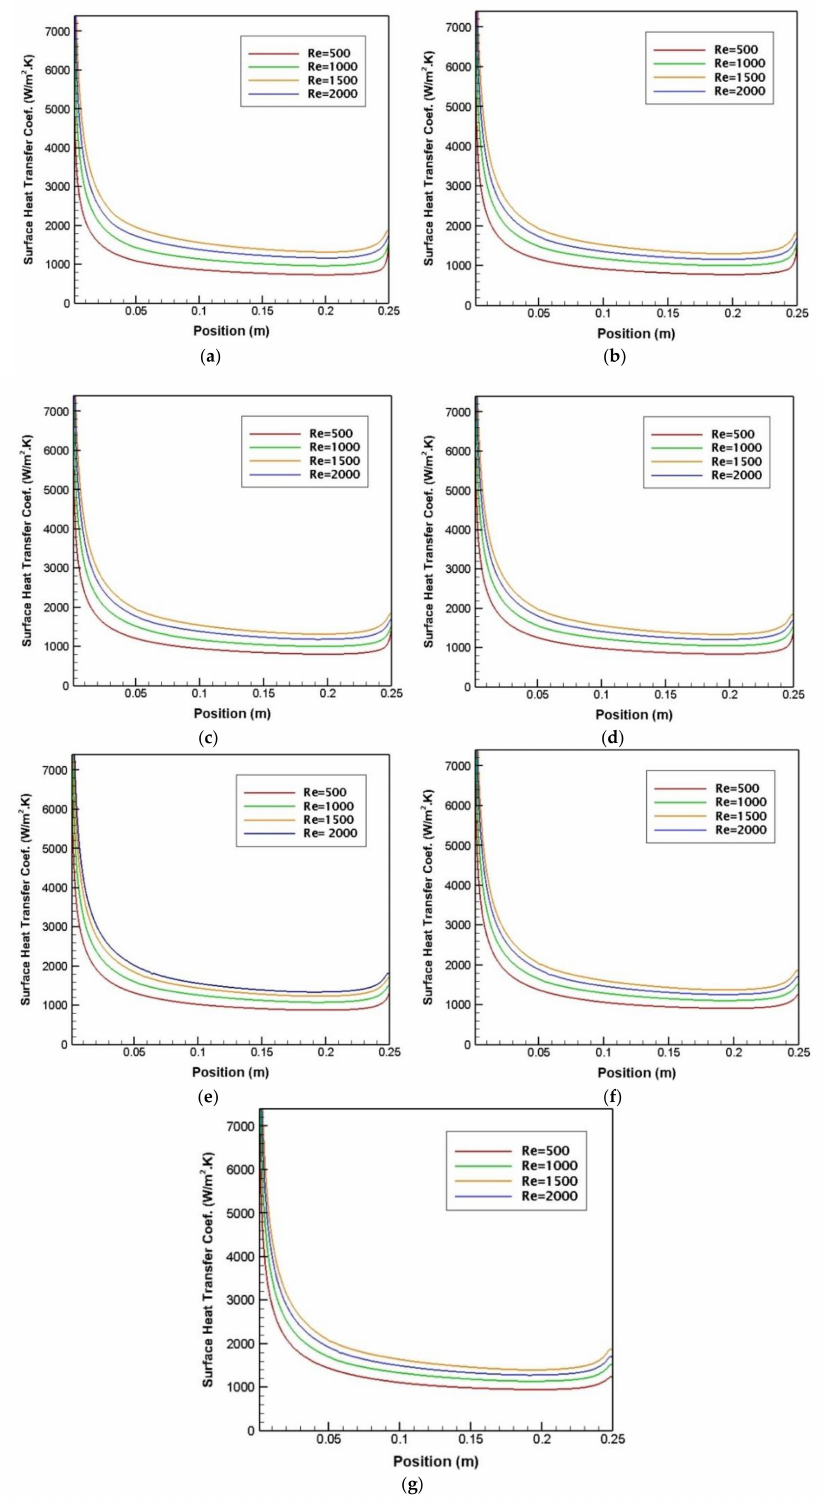
Figure 5. Variations of surface HTC in terms of the position at membrane angles of ( a ) 0 ◦ , ( b ) 15 ◦ , ( c ) 30 ◦ , ( d ) 45 ◦ , ( e ) 60 ◦ , ( f ) 75 ◦ and ( g ) 90 ◦